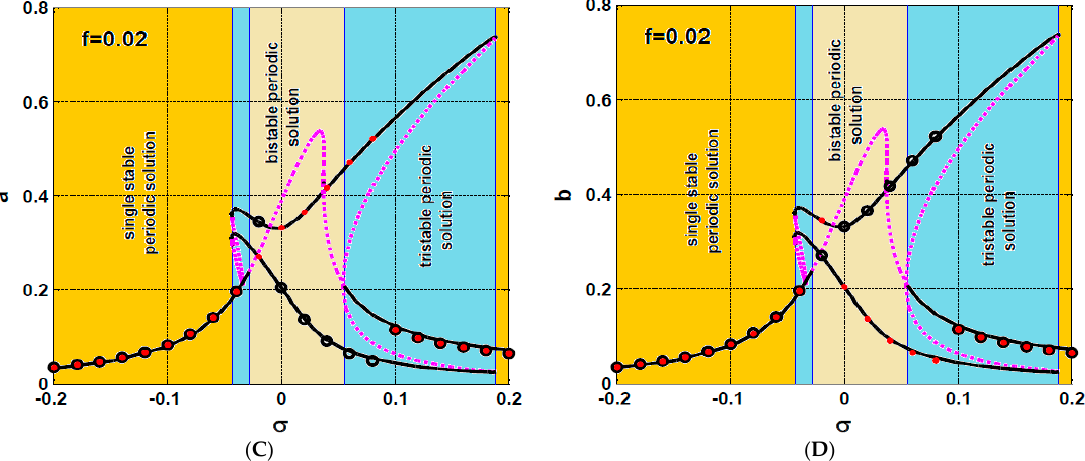
Figure 3. The rotor system 𝜎 — response curve at two different values of eccentricity 𝑓 when the IRC controllers are turned off: ( A , B ) the system oscillation amplitudes a and b when 𝑓 = 0.01 and ( C , D ) the system oscillation amplitudes a and b when 𝑓 = 0.05 .